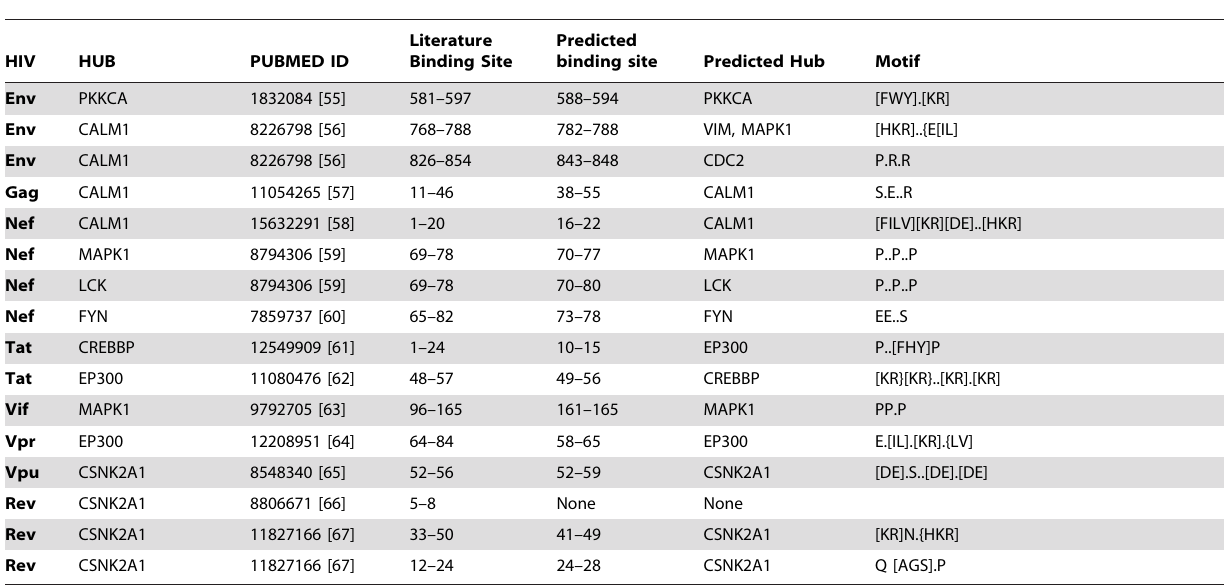
Table 4. Experimentally determined binding sites of HIV-1 proteins to hub proteins and their intersection with motifs discovered in our analysis.